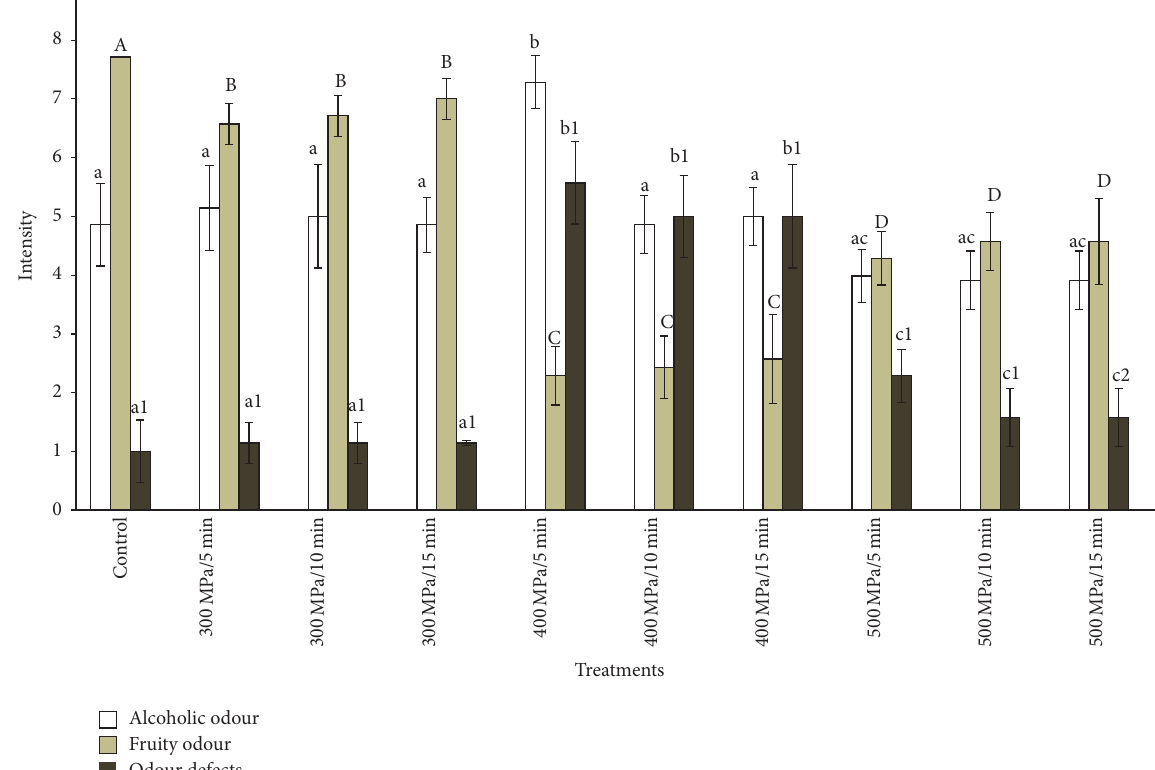
Figure 3: Effects of HHP on white wine sensory attributes. Different letters in each bar indicate significant differences between mean values ( 𝑝 ≤ 0.05